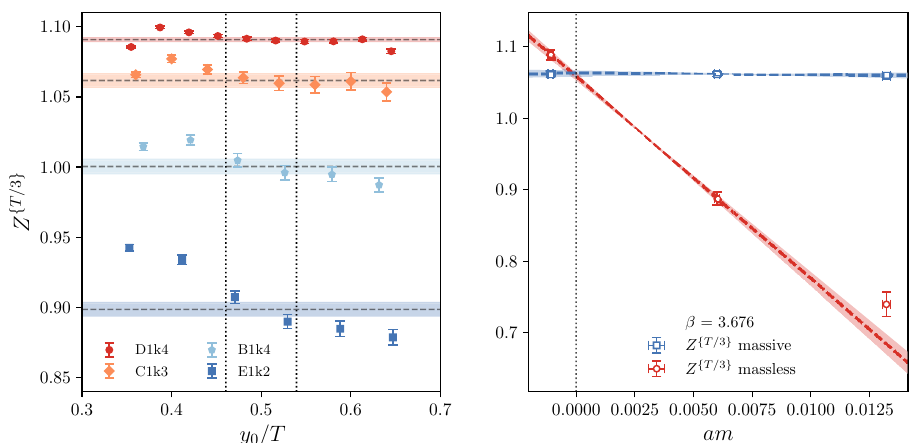
Fig. 5 Left: Ward identity estimates of Z , plotted against time y 0 / T , for one representative ensemble for each lattice spacing (except for β = 3 . 3, corresponding to the coarsest lattice). The dashed vertical lines bracket the two central time slices that determine the final value of Z . Right: chiral extrapolation of Z at fixed β obtained from the Ward identity with the mass term (squares) and without it (diamonds). In the